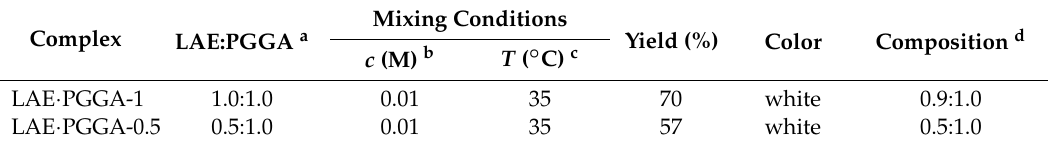
Table 1. Results for the preparation of LAE·PGGA complexes.